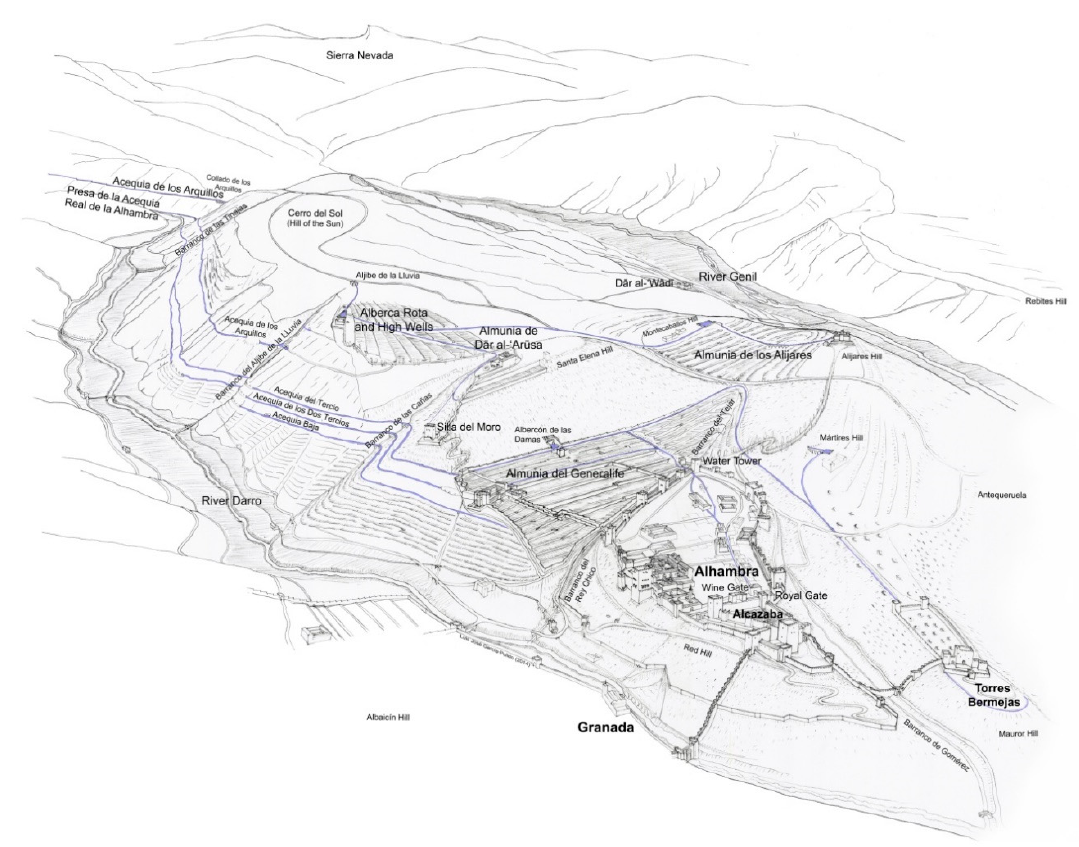
Figure 2. Hypothesis on the development of the Alhambra and its surroundings at the time of maximum expansion during the second half of the fourteenth century. Created by authors.